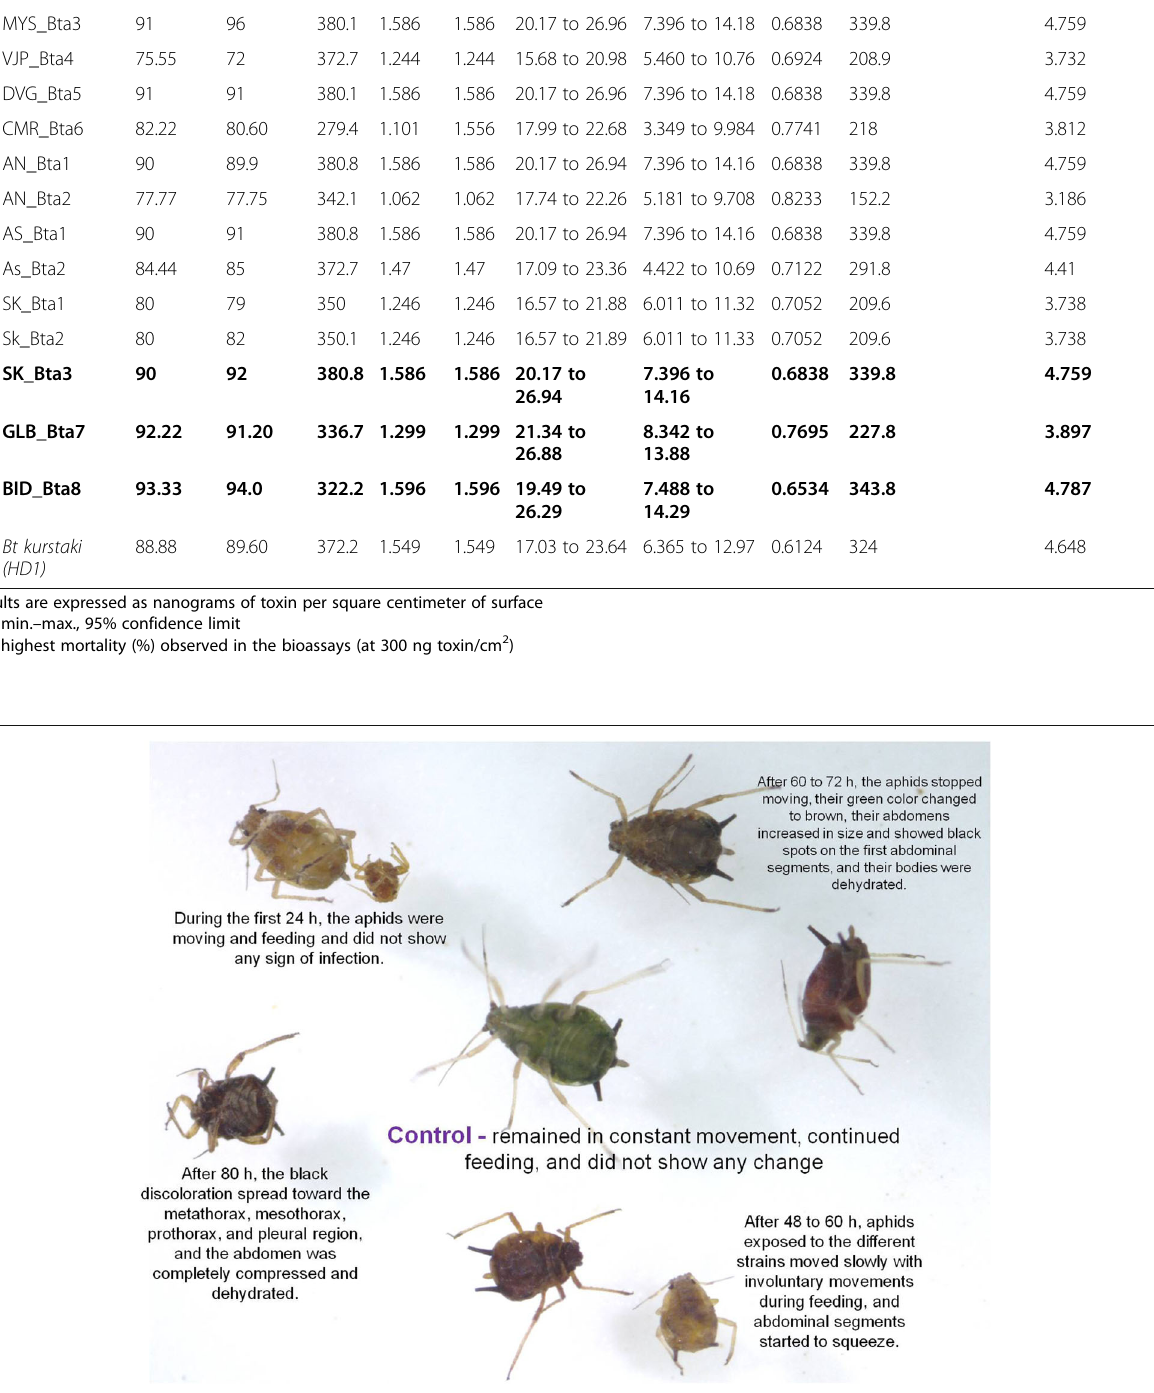
Fig. 7 Infection signs in A. gossypii caused by native strains of Bacillus